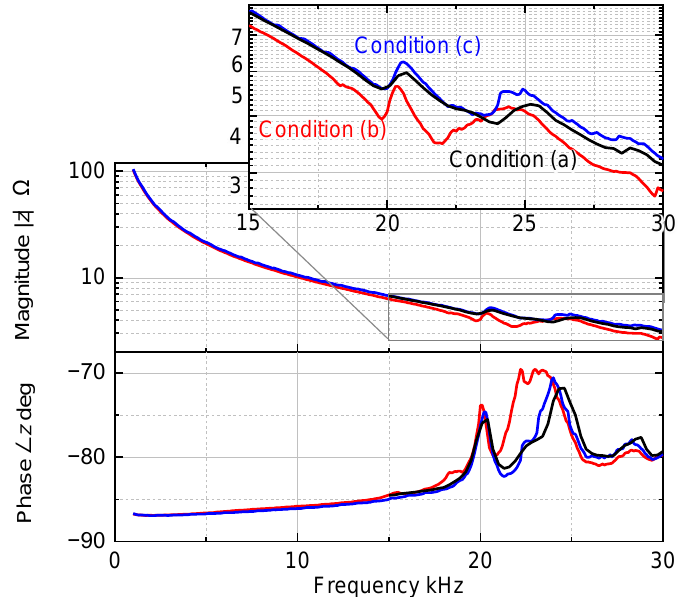
Figure 7. Impedance of the PESA when a bias voltage of 50 V and sinusoidal voltage of 13 V were applied to the PESA with natural heat dissipation (red) and with forced liquid cooling (blue). The black line represents the impedance with natural heat dissipation without sufficient time for the temperature to rise.